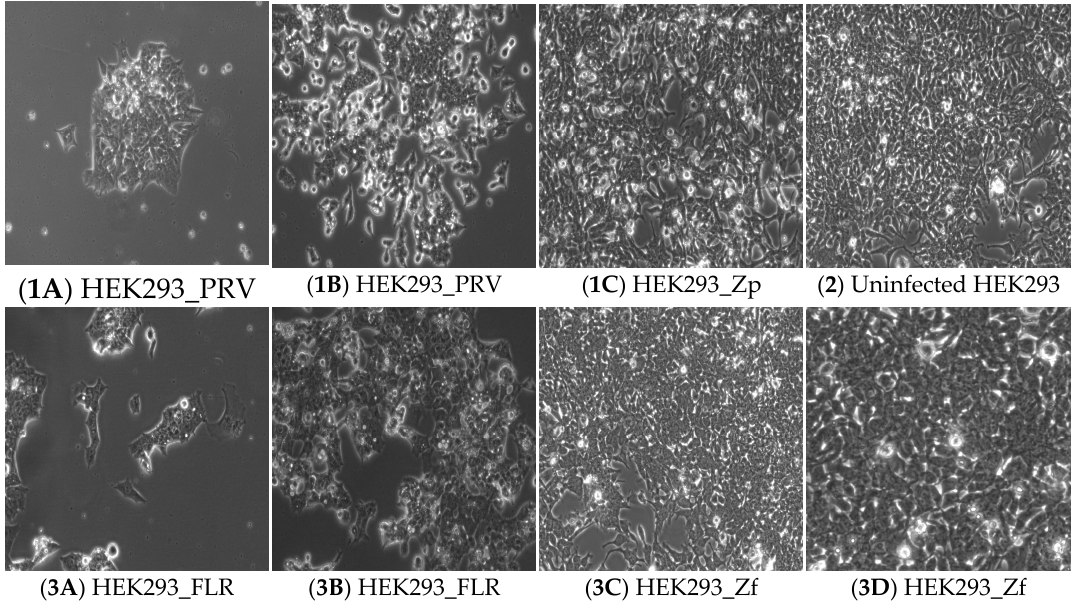
Figure 1. Morphology of HEK293 cells infected by the PRV (Puerto Rico) and FLR (Colombia) strains of ZIKV (ZIKA virus) at different stages. Photo micrographs (100×) of small clusters of viable HEK293 cells continued to adhere on the flasks at week 4 in PRV-ZIKV infected culture ( 1A ) and FLR-ZIKV infected culture ( 3A ). Proliferation of HEK293 cells was evident at week 6 in PRV-ZIKV infected culture ( 1B ) and FLR-ZIKV infected culture ( 3B ) after fresh medium was provided. The monolayer HEK293 cells re-established in PRV-ZIKV infected culture (HEK293_Zp, 1C ) and FLR-ZIKV infected culture (HEK293_Zf, 3C ) after fresh medium was provided weekly. Monolayer of non-ZIKV infected HEK293 cells (100 × ) at Day 5 ( 2 ). Higher magnification (200 × ) of the monolayer formed by HEK293_Zf cells ( 3D